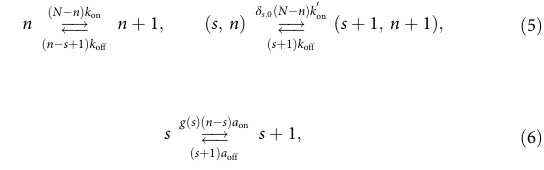
video were then ensemble averaged to obtain 〈 MSD 〉 . Distributions of MSDs and effective diffusivities ( D eff ) were calculated as previously demonstrated 16 . MSD may also be expressed as MSD = 4 D 0 τ α , where α , the slope of the curve on a log-log scale, is a measure of the extent of impediment to particle diffusion ( α = 1 for pure unobstructed Brownian diffusion; α < 1 indicates sub-diffusive motion due to interactions with the elastic as well as viscous properties of the polymeric gel).